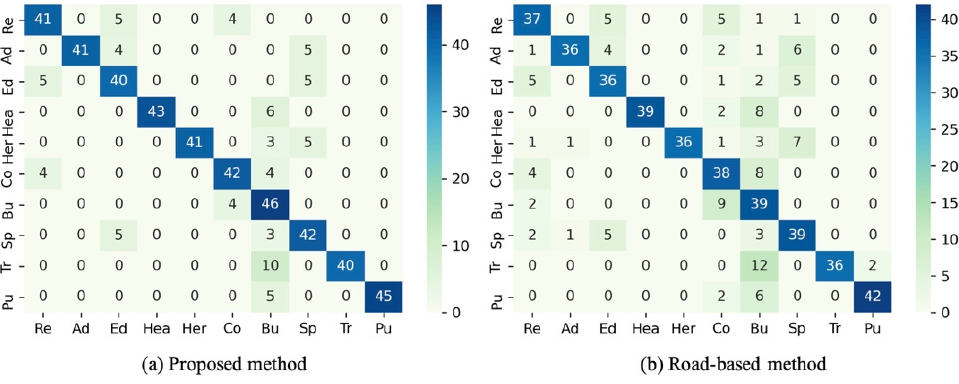
Figure 15. Confusion matrix of the classification results .